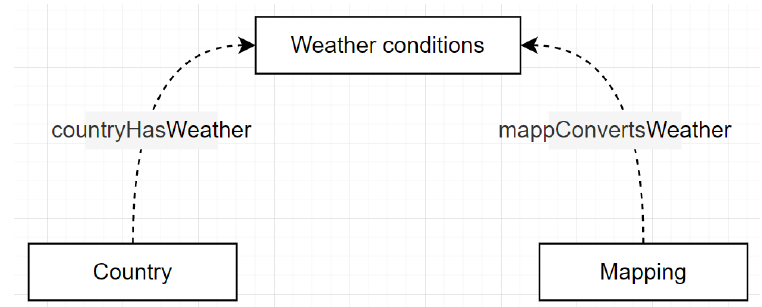
Figure 4. Ad hoc binary relation diagram defined for RustOnt .